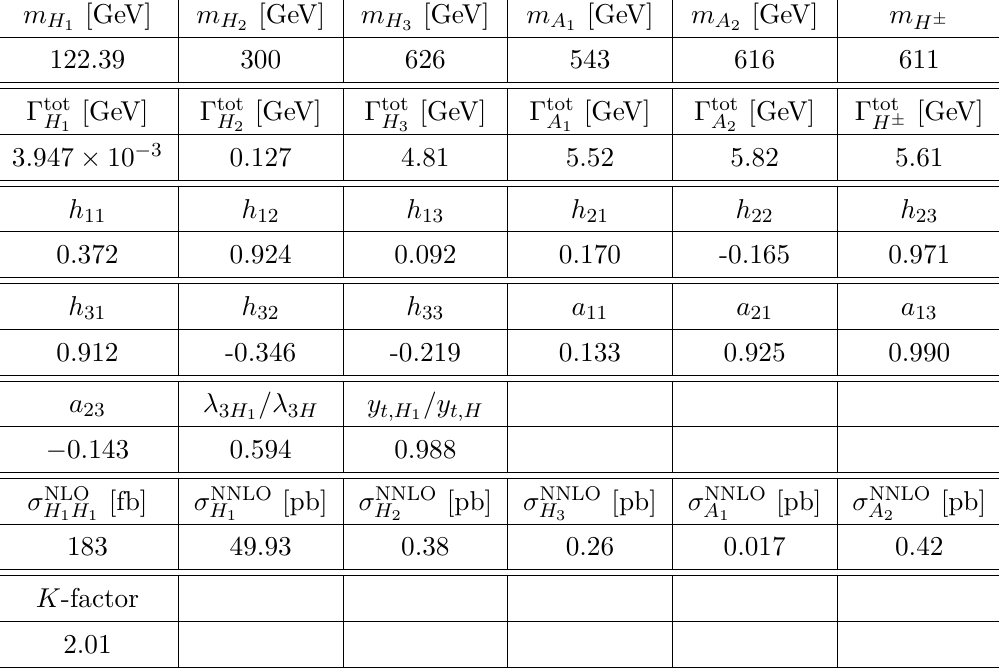
Table 18 . BP10 Additional information related to double and single Higgs